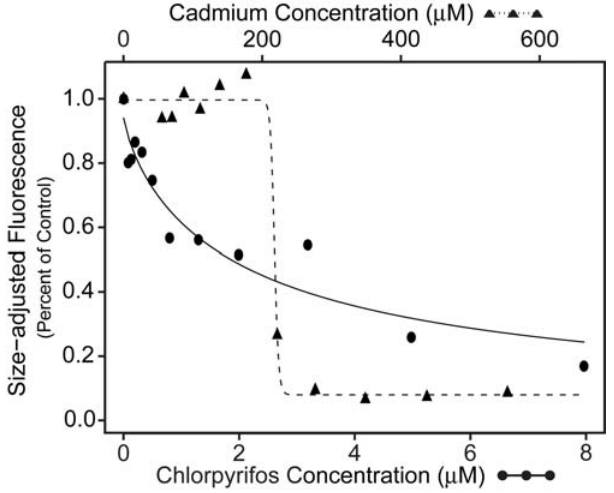
Figure 4. Effect of chlorpyrifos and cadmium on C.elegansfeeding. Fitted concentration-response curves of single representative experi- ments based on observed mean size-adjusted fluorescence measure- ments as a percent of the control for two toxicants, cadmium ( triangles, top axis ) and chlorpyrifos ( circles, bottom axis ). Each point represents approximately 120 nematodes on average, with counts ranging from 104 to 141.